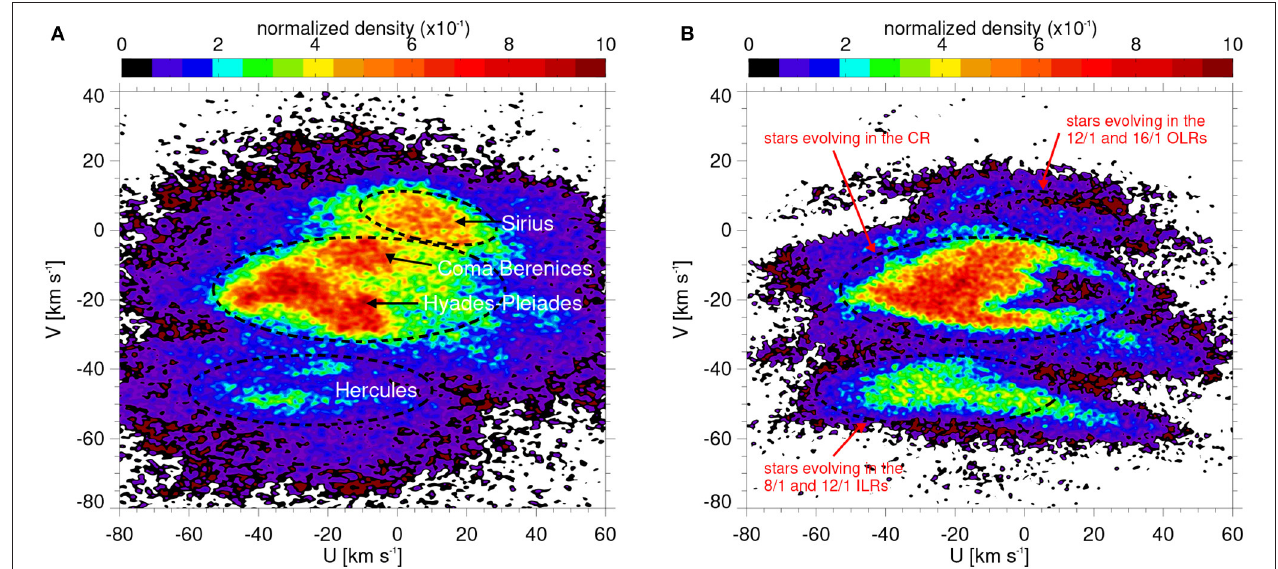
FIGURE 7 | (A) U – V –velocity distribution from the Gaia stars within 150pc from the Sun. The density distribution of stars in the plane is obtained by a kernel density estimation technique in two-dimensions, giving the normalized densities. The dashed ellipses separate regions of enhanced stellar density, which are associated to the MGs of Coma Berenices, Hyades, Pleiades, Sirius, and the weaker but important Hercules stream. (B) U – V plane of the SN resulting from the test-particle simulation by Barros et al. (2020). The same set of dashed ellipses on panel (A) is overlaid; each ellipse is associated to stars evolving at some high-order LRs, either ILRs or OLRs, as well as the CR. Adapted from Barros et al.